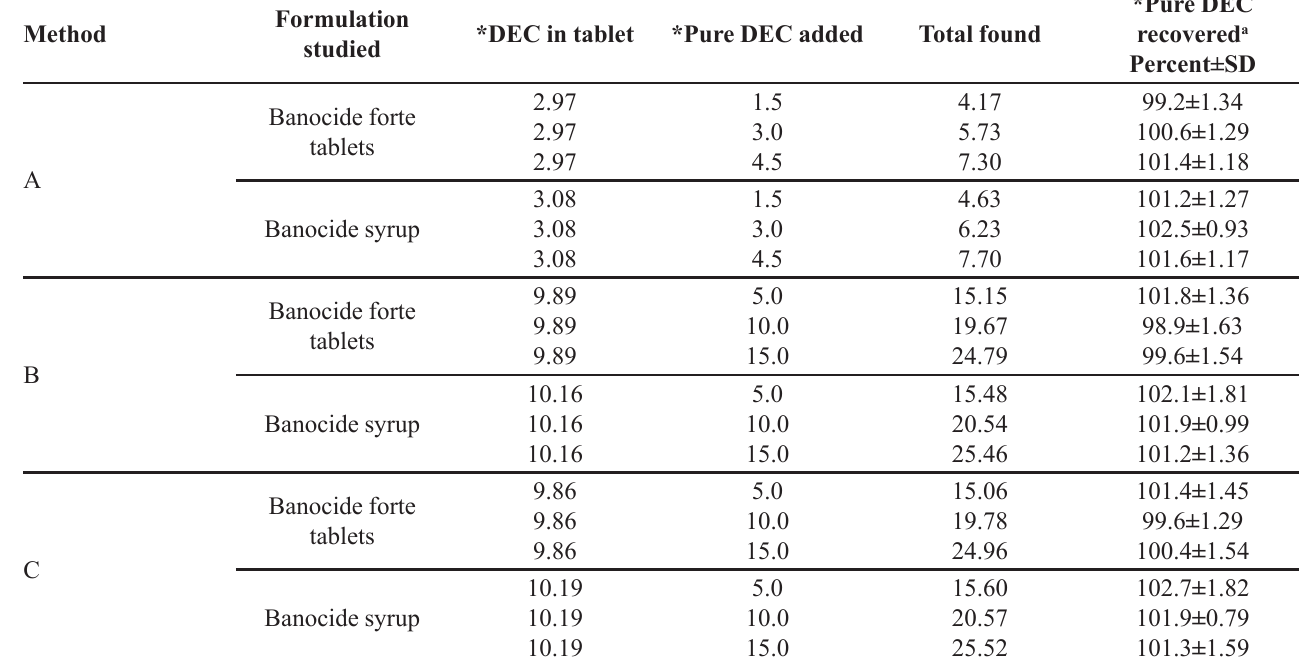
TABLE IV - Results of recovery study via standard addition